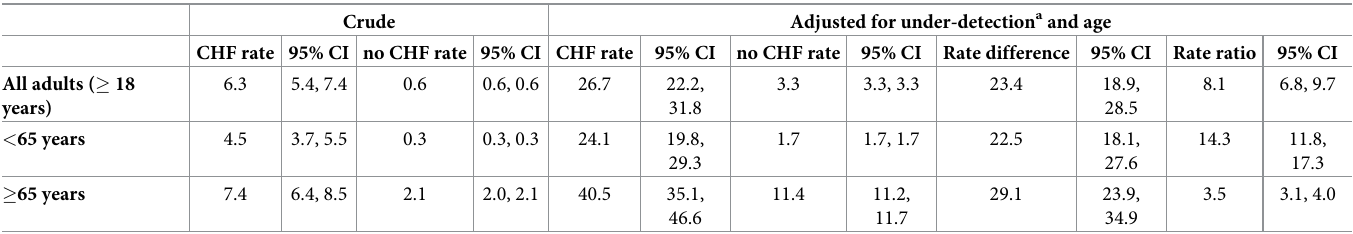
Table 2. Rates (per 10,000 population) of RSV-associated hospitalization by congestive heart failure (CHF) status, RSV-NET, 2015–2017 (N = 2042). Crude Adjusted for under-detection a and